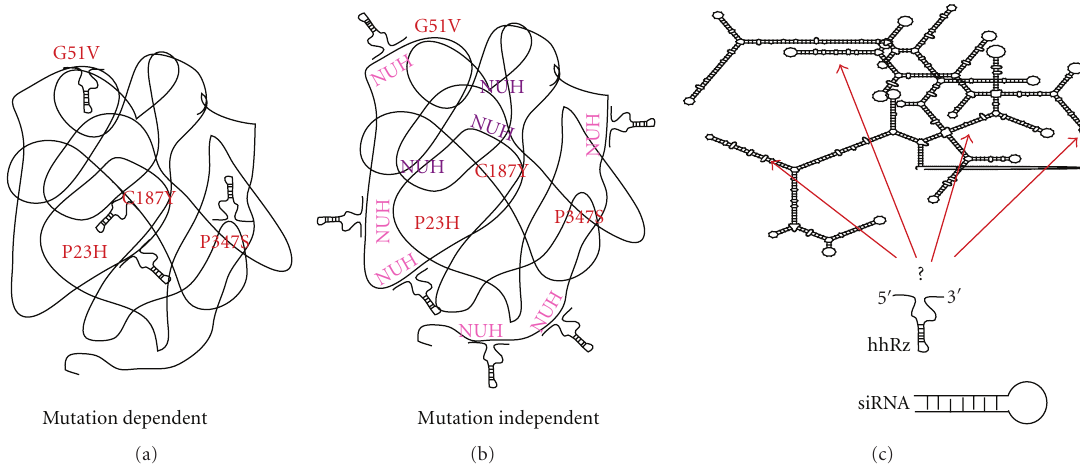
Figure 7: Comparison of mutation independent and mutation dependent strategies to PTGS therapy. The schematic representation shows two folded mRNAs, one in which a MD strategy is being used to attack discrete mutations which obligate the site of attack to regions that are likely to be buried, and the other is an MI strategy, where the best (most accessible) NUH ↓ (lavender) or RNAi cleavage site is sought for use. This challenge applies to hhRz or RNAi type